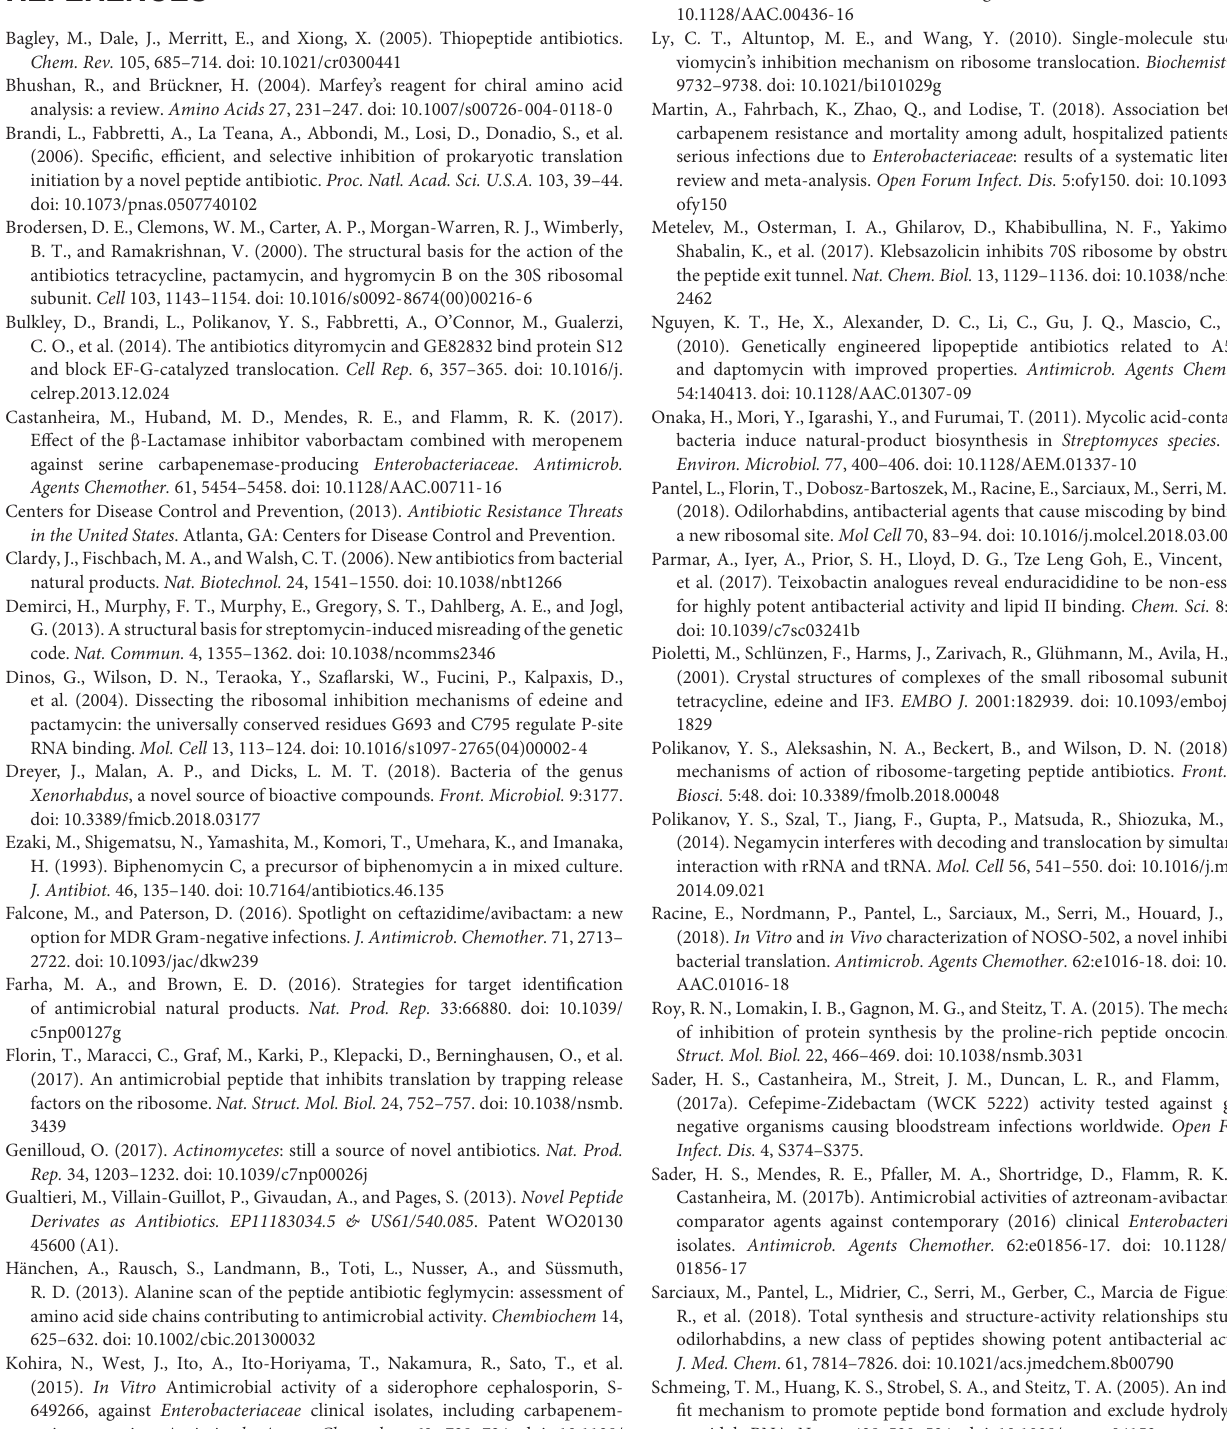
6:ofz123. doi: 10.1093/ofid/ofz123